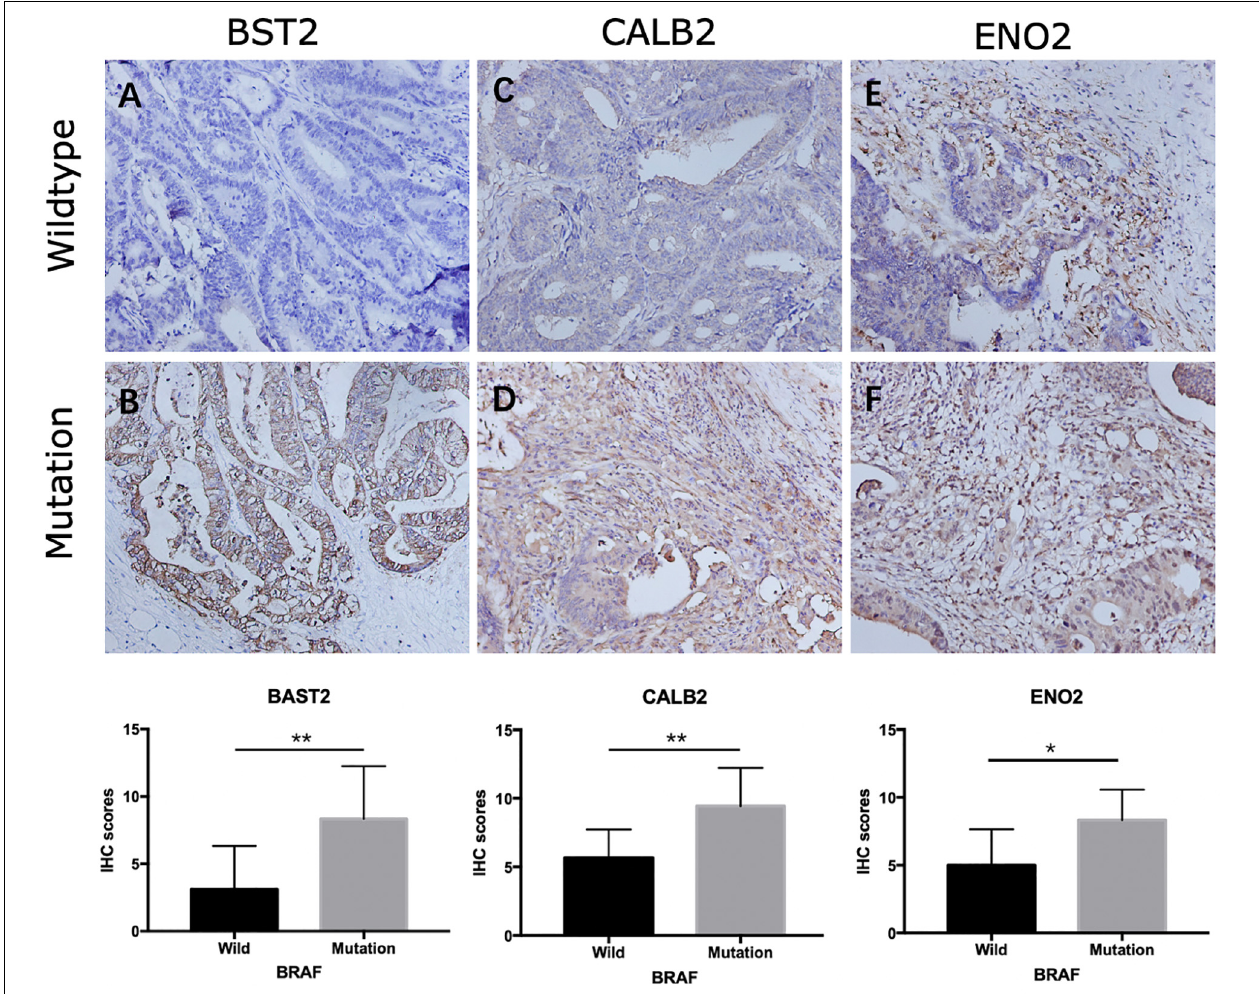
FIGURE 6 | Representative IHC staining showing expression of overall survival-related genes in colon cancer. Staining of BST2 (A,B) , CALB2 (C,D) , and ENO2 (E,F) in BRAF wild-type (A,C,E) and BRAF mutated (B,D,F) samples at magnification × 200. * p < 0.05, ** p < 0.01, *** p <